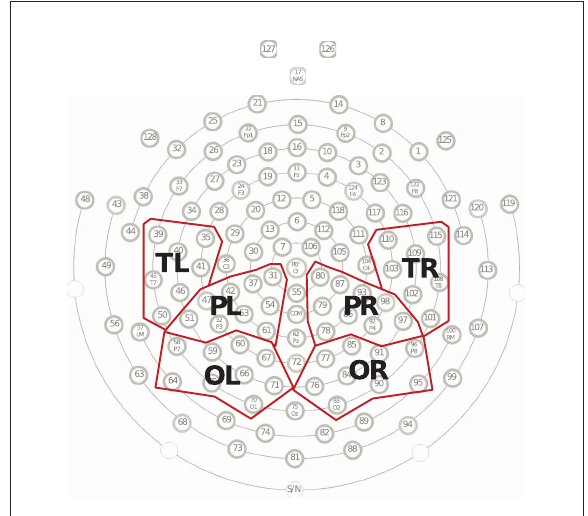
FIGURE1 Electrode groupings. Fifty of 128 electrodes were divided into six regions, including the left temporal region (TL), right temporal region (TR), left parietal region (PL), right parietal region (PR), occipital region (OL), and right occipital region (OR). Each region contained between seven and nine electrodes, and the average of these electrodes represented the EEG responses for that scalp region.